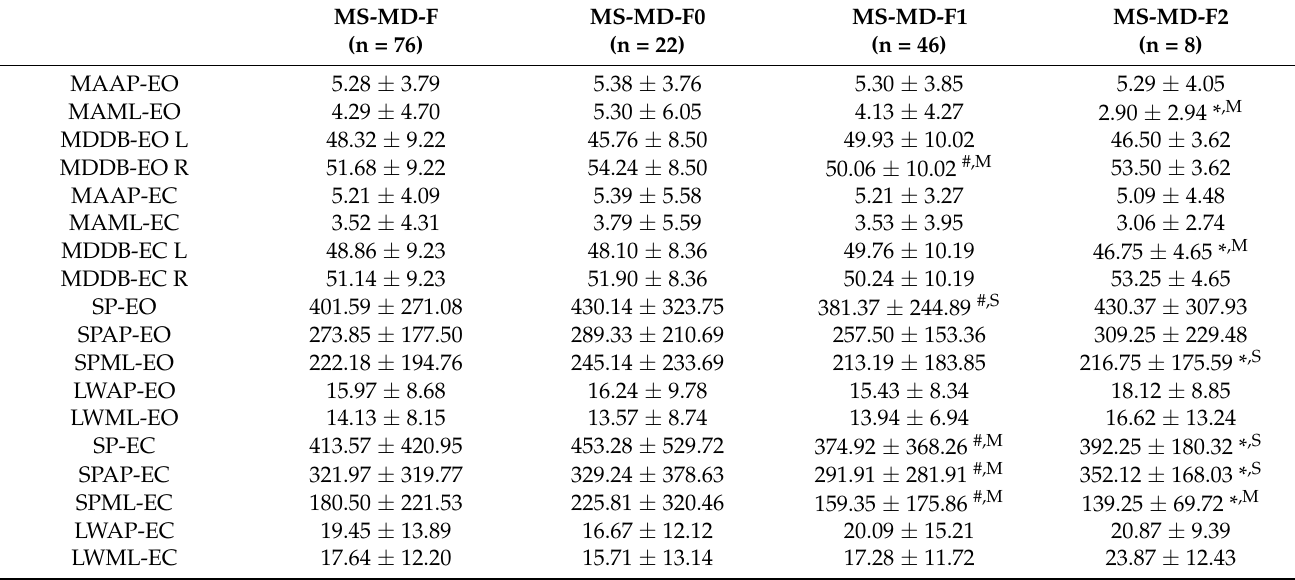
Table 2. The differences in stabilometric platform results between different levels of cognitive impairment in multiple sclerosis patients with moderate disability and fatigue